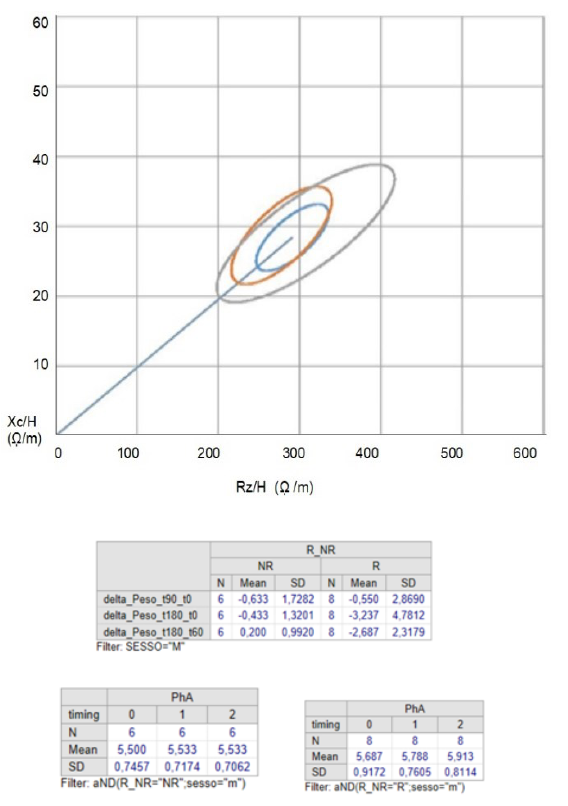
Fig.1: The graph compares male oncologic patients, both R and NR, at T0 (baseline) and T6 (evaluation after 6 months). Male oncologic patients at T0 compared to T6: R are marked by orange color and NR by grey color.